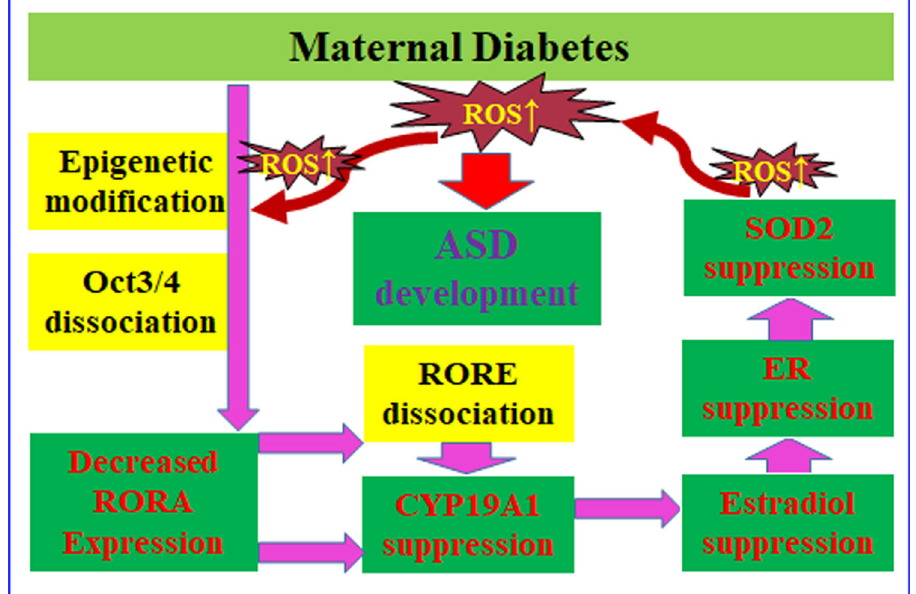
Fig. 9 Schematic model for maternal diabetes-mediated RORA suppression and contribution to ASD development. Abbreviations: ASD autism spectrum disorders, CYP19A1 cytochrome P450 family 19 subfamilies A member 1, ER estrogen receptor, Oct3/4 octamer-binding transcription factor-3/4, RORA retinoic acid-related orphan receptor alpha, RORE retinoic acid-related orphan receptor elements, ROS reactive oxygen species, SOD2 superoxide dismutase